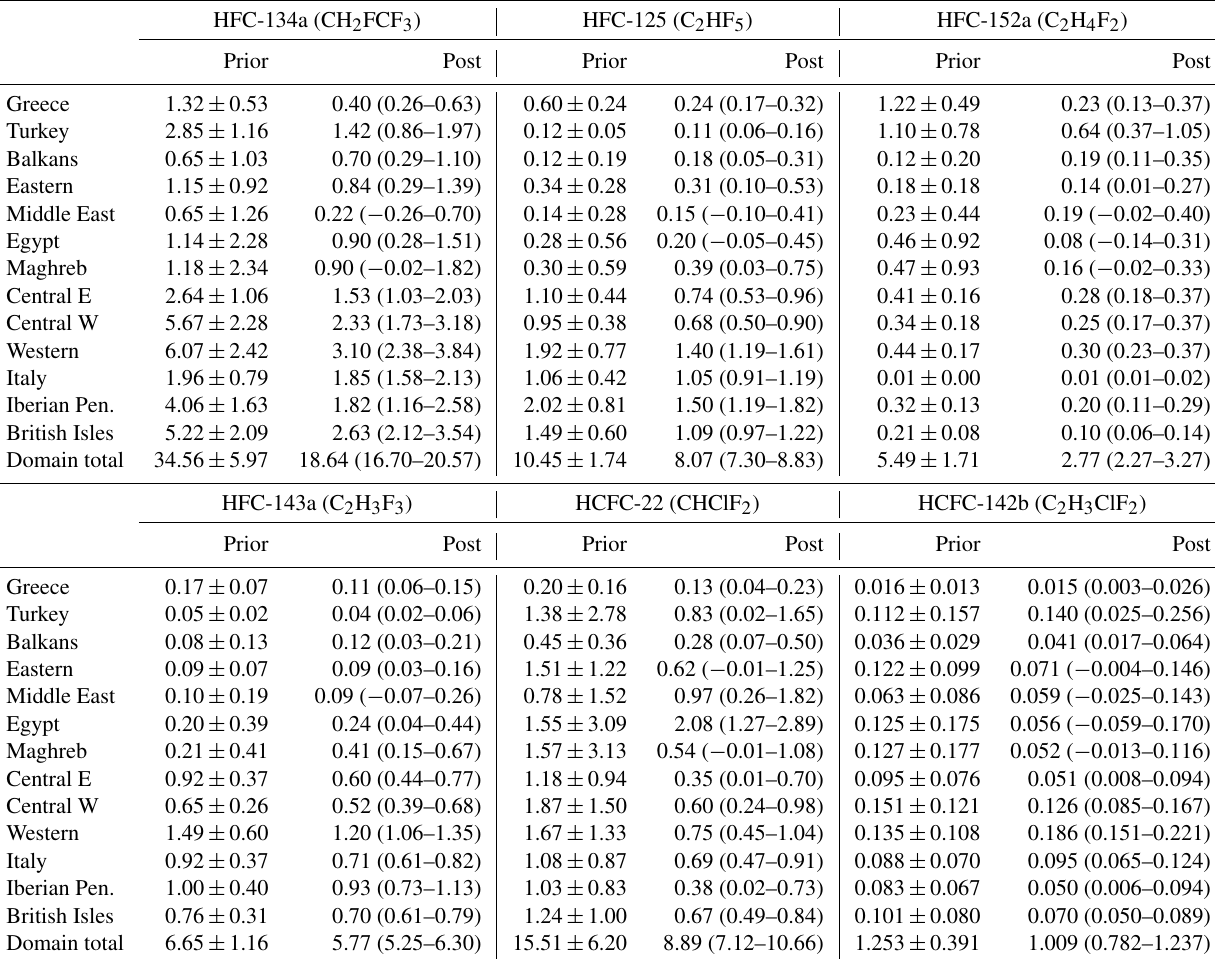
Table 3. Regional emissions as estimated in the a priori inventory and by the atmospheric inversion. All values are given in Ggyr − 1 . A posteriori estimates are shown as the mean values, derived from the BASE inversion and the sensitivity inversions S-ML, S-MS, S- UH, S-UL, S-PH and S-PL. The uncertainty range gives the maximum range provided by the respective mean values of all inversions plus the mean of the analytic uncertainty ( p <0.05) estimated by each individual inversion. Smaller and distant countries were